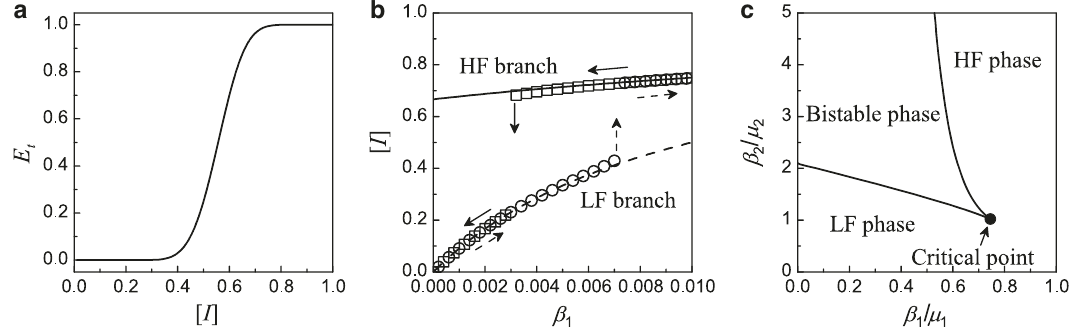
Fig. 2 Behaviors of MR model. a Probability E t ([ I ]) in the mean- fi eld theory [Eq. (4)] as a function of [ I ]. b Dependence of [ I ] on β 1 in the steady state for β = 2.0, μ = 0.01, and μ = 1. The high-failure (solid curve) and low-failure (dashed curve) branches are calculated by the mean- fi eld theory. The 2 1 2 simulation data are obtained by swabbing β 1 up and down in step of 0.002, starting with [ I ] 0 = 0 for β 1 = 0. The fi nal state of a value of β 1 is used as the initial state of the simulations for the next value of β 1 . The arrows indicate the simulation results when the value of β 1 moves up and down. c Phase diagram on the β 2 / μ 2 - β 1 / μ 1 plane as predicted by the mean- fi eld theory. Systems in the bistable phase will evolve either to a high-failure or a low-failure phase depending on the initial conditions. Beyond the critical point, there is no distinction between the low-failure and high-failure